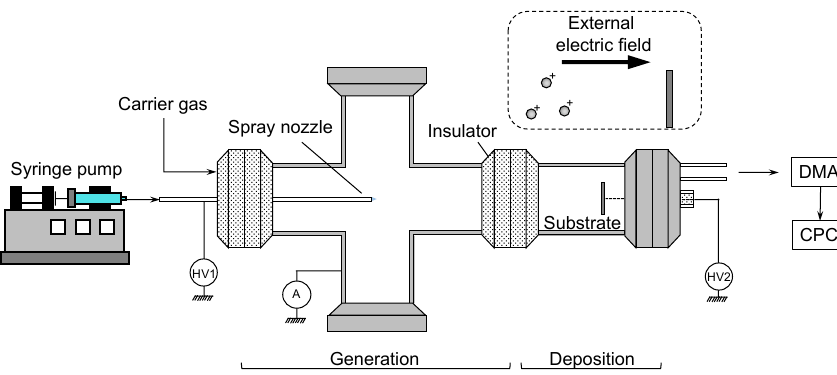
Figure 2. Schematic illustration of the electrospray system consisting of a generation and a deposition chamber. Table 1. Summary of intensity ratio I SERS /I NR at peak bands of 937, 970, 1039 and 2930cm − 1 for the AS, AS / SA and AS / sucrose particles and ambient PM. All Raman experiments were conducted at ambient temperature and 60%